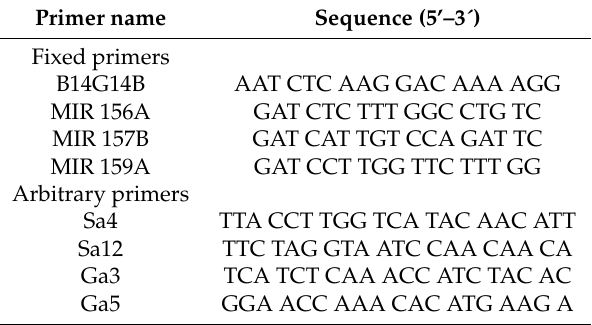
Table 1. List of soybean target region amplification polymorphism- (TRAP) marker